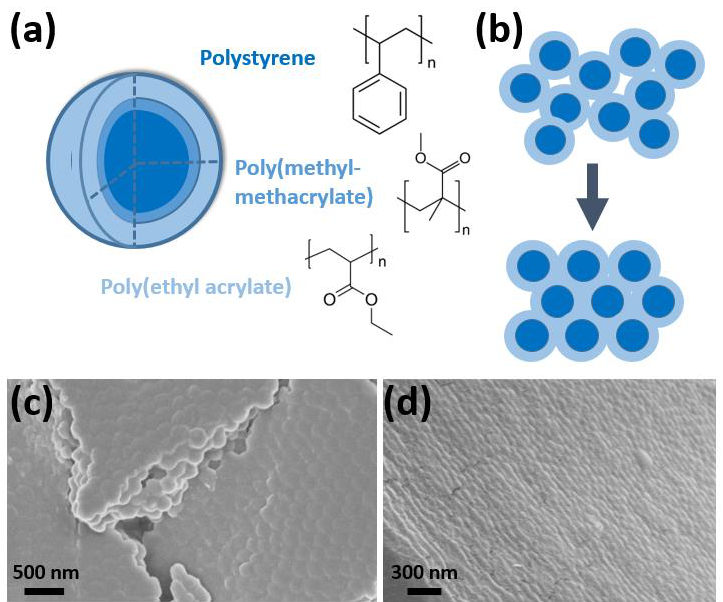
Figure 1. ( a ) The polymer opal core–shell particle, consisting of a polystyrene core, poly(methyl- methacrylate) grafting interlayer, and the poly(ethyl acrylate) shell, with the chemical structures of each layer shown. ( b ) The shear-assembly of these particles into random-hcp crystalline arrays is illustrated, with the interstices between PS cores filled by the grafted PEA matrix. The ordered surface of a 5 BIOS opal was imaged by scanning electron microscopy (SEM), as shown in ( c ), and ( d ) shows how the hexagonal close packing permeated the depth of the film after 40 BIOS passes. Changes in microporosity and homogeneity are a byproduct of the film preparation techniques for